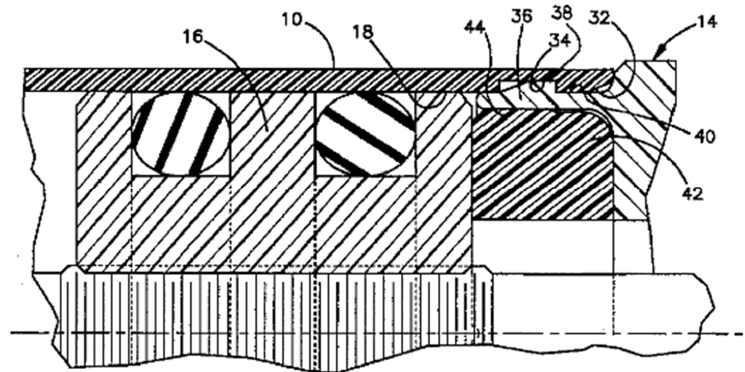
Figure 13. The method of connecting the composite barrel with the end cap [52].